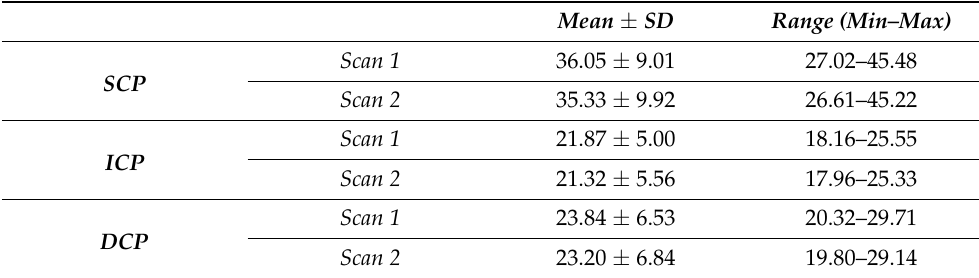
Table 2. Overall vessel density